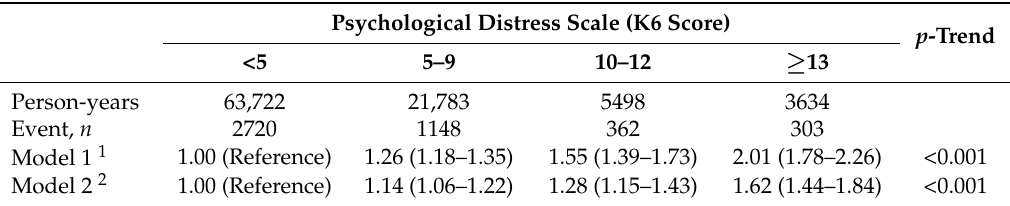
Table 2. Association between K6 score and incident functional disability ( n = 12,365).